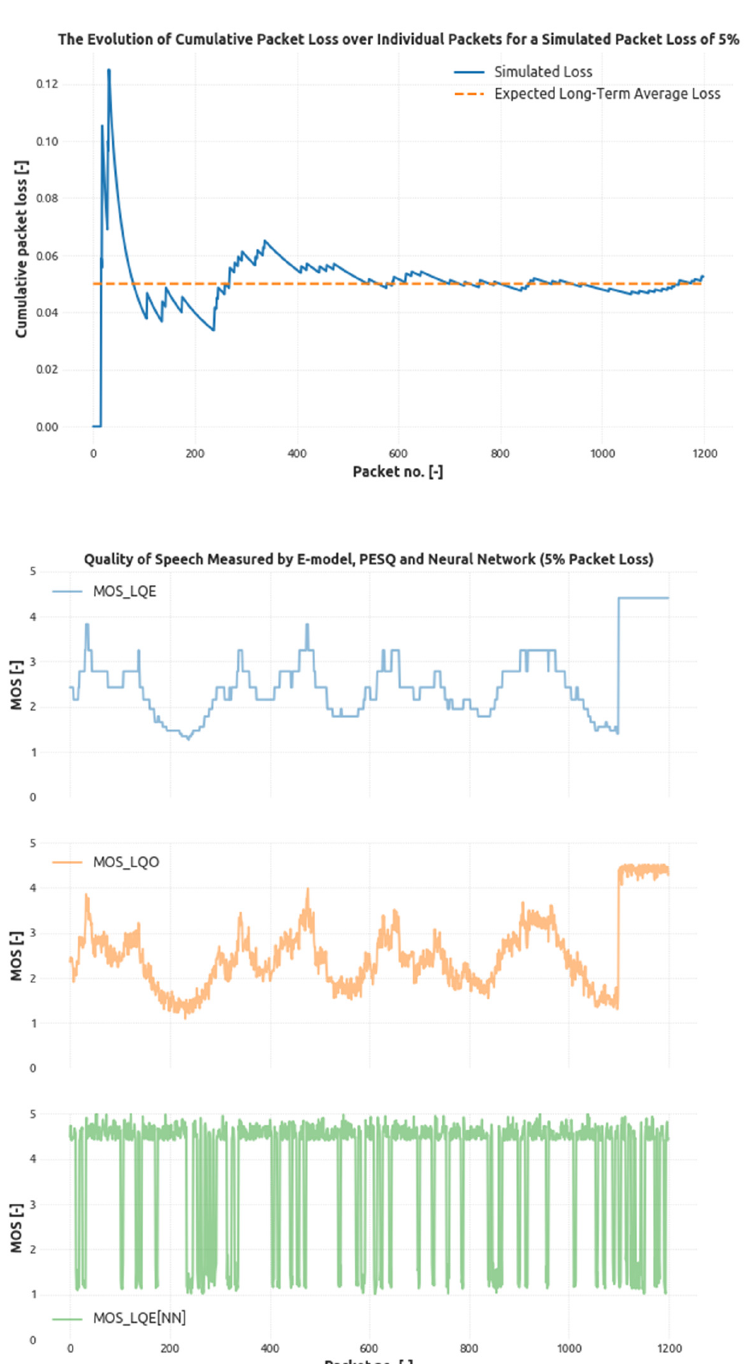
Figure 5. The evolution of the cumulative packet loss generated by the four-state loss model with given probabilities targeting the 5% loss threshold and related modeled speech quality score.